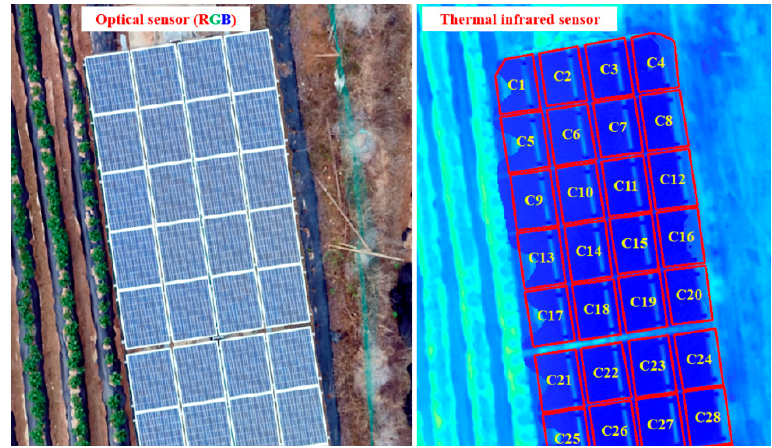
Figure 10. Failure case images taken at 7 p.m., when solar radiation is very low.